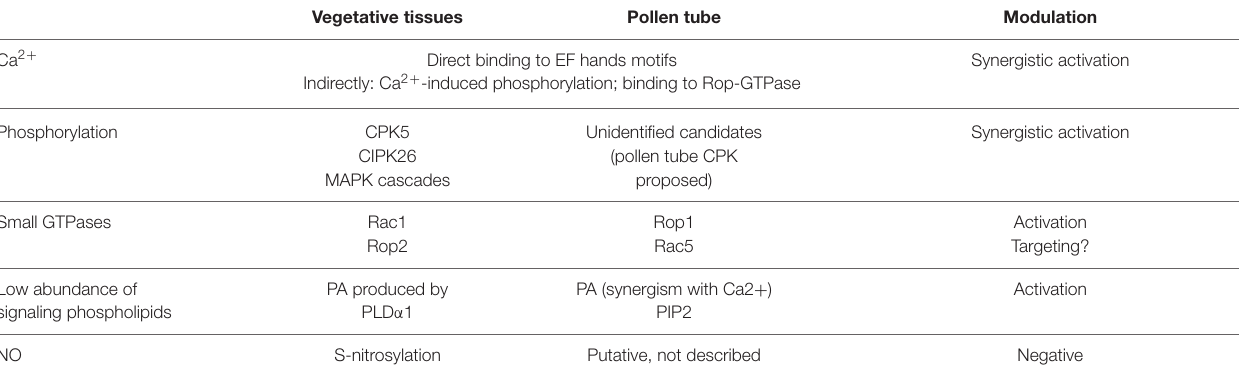
TABLE 1 | Rboh multiregulation in vegetative tissues vs. the pollen